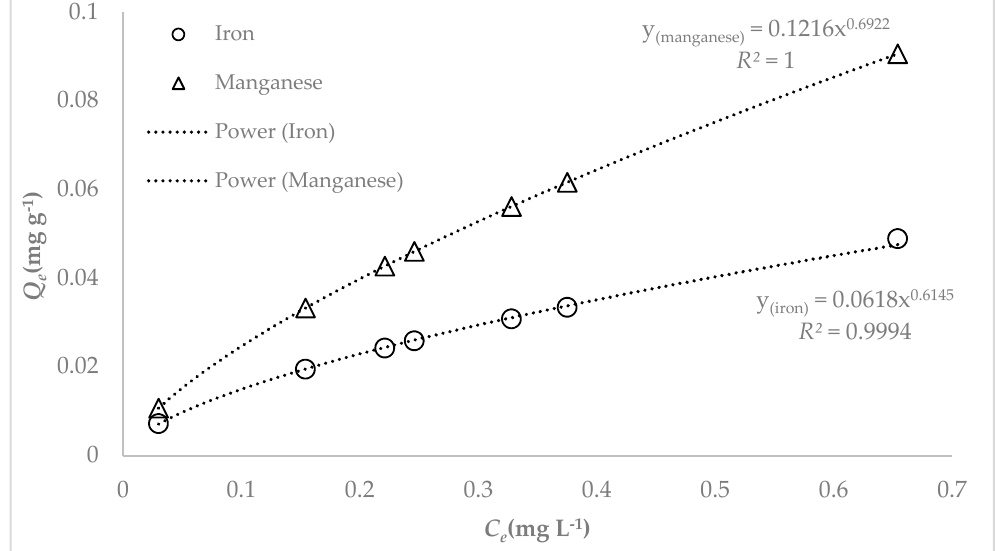
Figure 9. Non-linearized Freundlich adsorption isotherms obtained for the iron and manganese uptake onto zeolite Y during the adsorption studies. Initial Fe = 1.15 mg L − 1 ; Initial Mn = 1.61 mg L − 1 ; adsorbent dose = 1.0, 2.0, 2.5, 3.0, 3.0, 4.0 and 4.5 g L − 1 , T = 25 °C; water pH = 6.5.